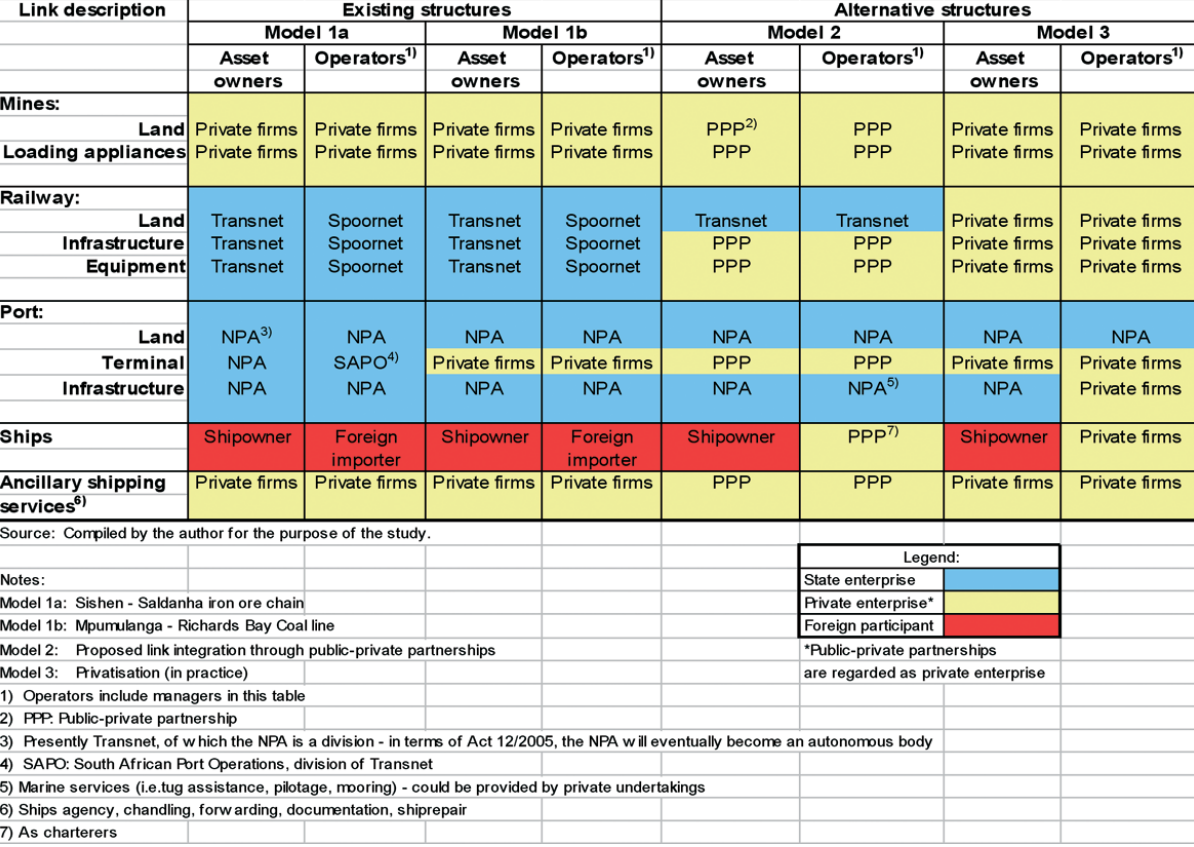
Table 1: Existing and alternative structures of South Africa’s major supply chains for the export of minerals and